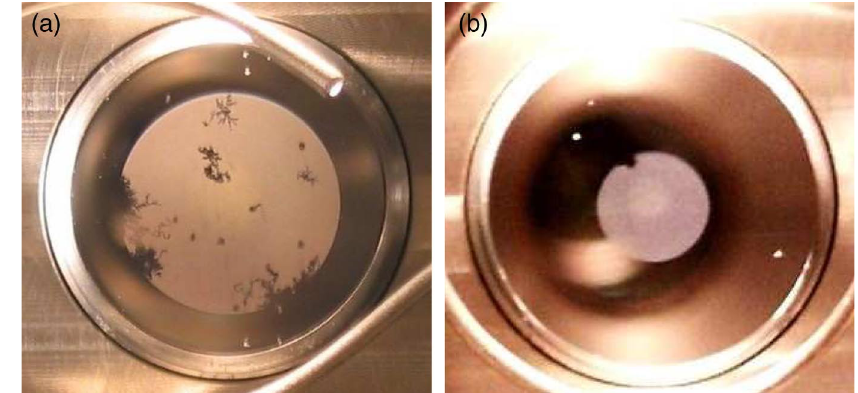
FIG. 10. (Color) Photographs: (a) cathode No. 60.1 in March 2004 and (b) cathode No. 43.2 in February 2005. Cathode No. 60.1 has a Te film of diameter 10 mm and cathode No. 43.2 has a film of diameter 5 mm. The mirrorlike Mo plug surface reflects the images Cs 2 of the viewport and the flange of the vacuum chamber. The metal wire visible in the corners of the picture is the anode installed for QE measurements using a UV